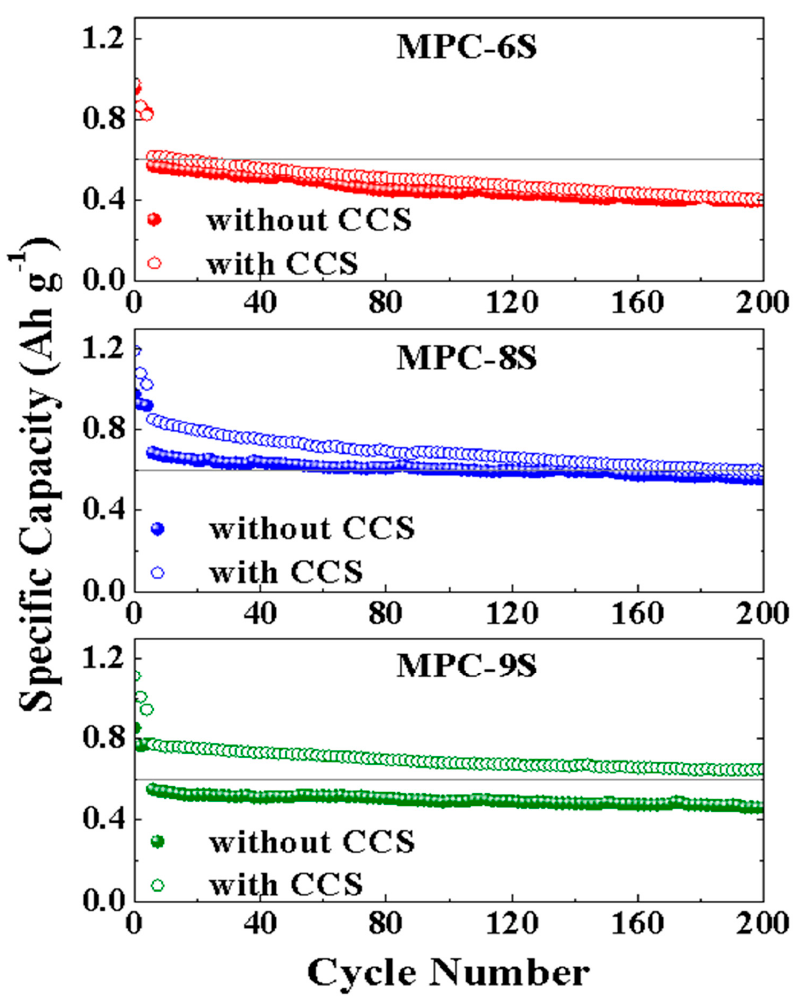
Figure 9. Cycling performance of the MPC-6S, MPC-8S, and MPC-9S cells coupled with PP/CCS separator. Table 3. Cathode materials and their properties for Li-S